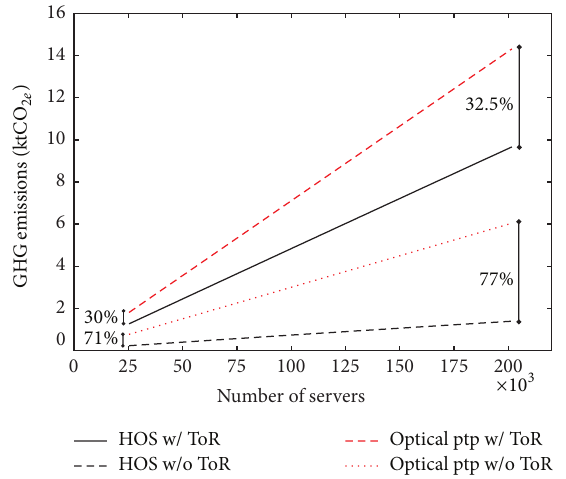
Figure 11: Greenhouse gas emissions per year of the HOS and the optical ptp networks as a function of the size of the data